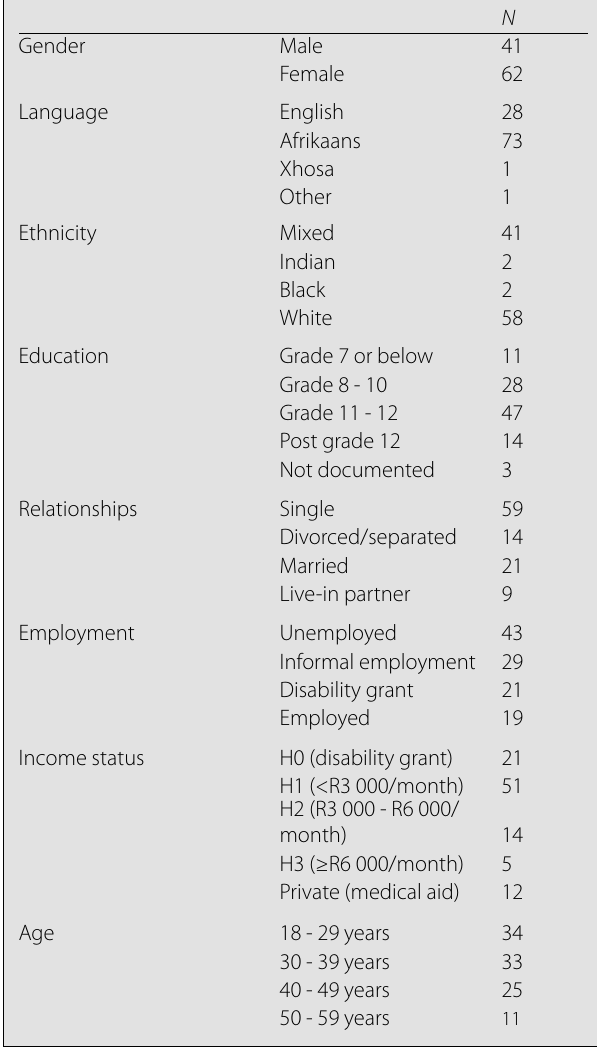
Table I. Demographic characteristics of